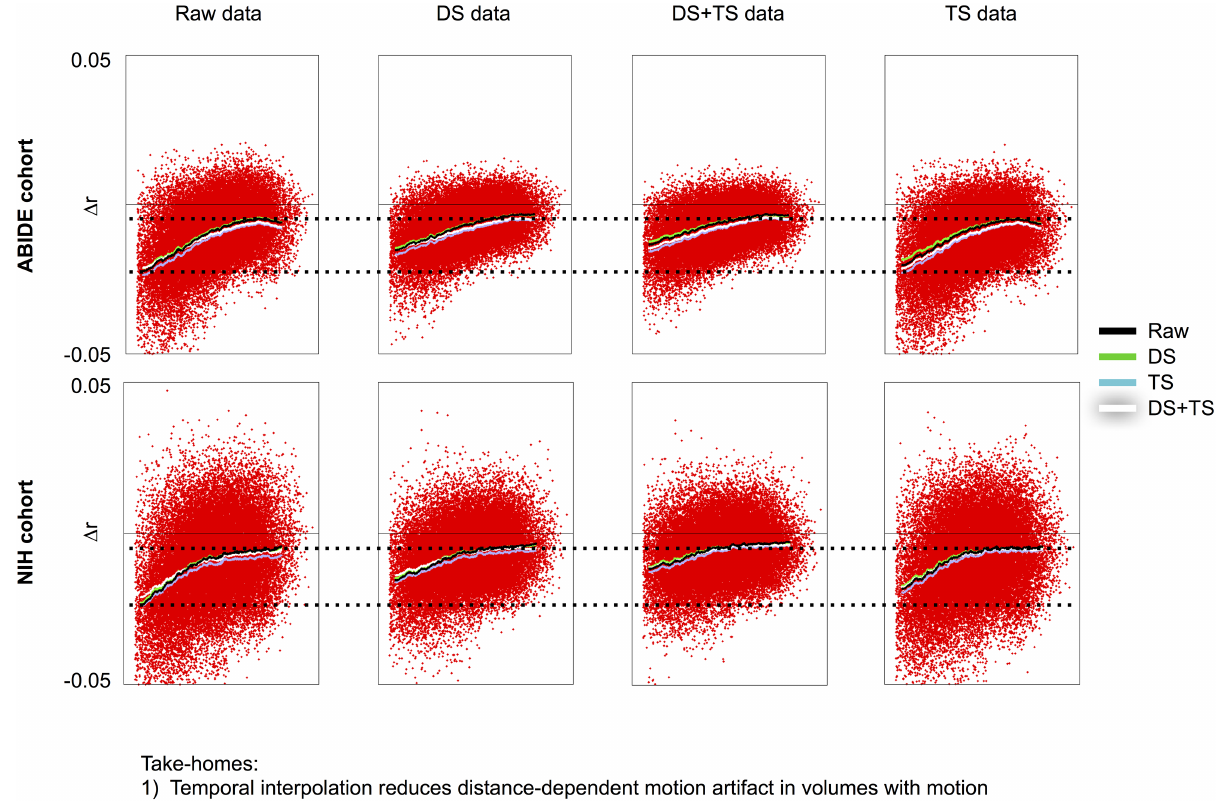
Fig 5. Temporal interpolation reduces distance dependent artifact. For the NIH and ABIDE cohorts, scrubbinganalysesin raw, DS, DS +TS, and TS data are shown using severalversions of FD traces at a 0.2 mm threshold.From left to right, the volumes being censoredare not changing,all that changesis the data undergoingcensoring. Note that the slope of the red points decreases in DS and DS+TS data, indicatingthat smaller amounts of distance-dependent artifact are present in these volumes.Similar data with the same effects are shown for all cohorts in S6 Fig. The same result is seen regardlessof threshold used (data not shown). The x-axis represents distance,spanning 0–180